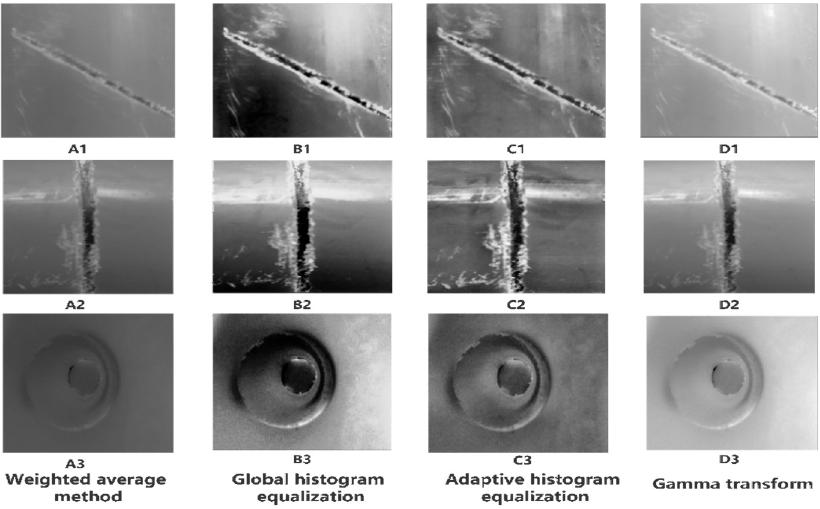
Figure 4. Comparison of pipeline defect image enhancement effect.